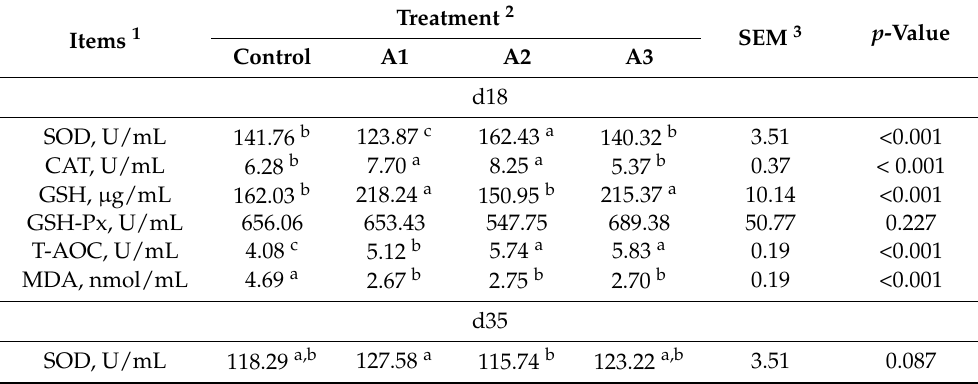
Table 4. Effects of acidifiers on antioxidant capacity in